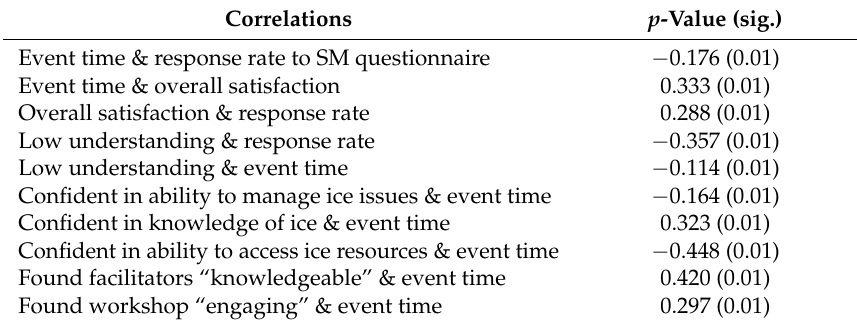
Table 3. Summary statistics of results using clicker technology at the “AOD-our-way” workshops.